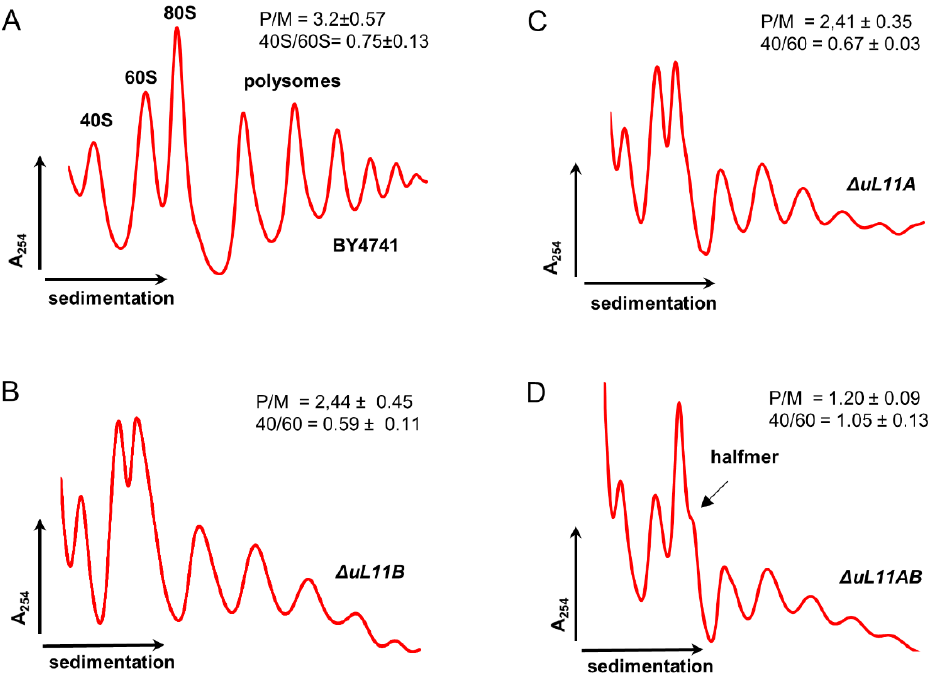
Figure 4. Polysome profile analysis. Polysome profiles obtained for the control BY4741, ∆ uL11A , ∆ uL11B , and double disruptant ∆ uL11AB strains. The sedimentation vector of the ribosomal fractions is indicated by a horizontal arrow, and optical density analysis at 254 nm is shown on the y-axis; the position of individual ribosomal subunits and half-mers is indicated. ( A ) wild type cells; ( B , C ) the single deletion strains; ( D ) double disruptant mutant. Insets—P / M, the polysome to monosome ration; 40S / 60S—ratio of small to large ribosomal subunits.